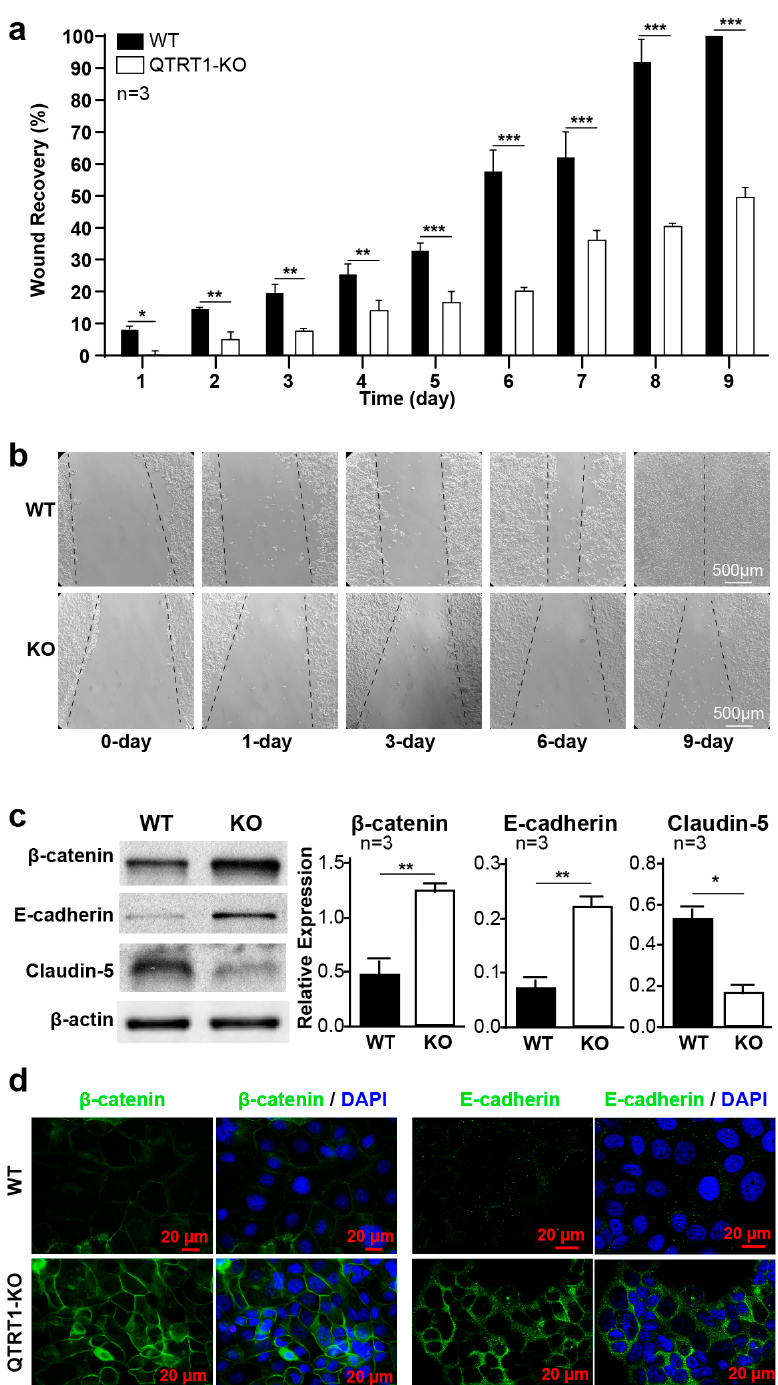
Figure 2. Knockout of QTRT1-suppressed cell migration and altered cell adhesion and tight junctions. ( a ) Wound healing analysis of wildtype and QTRT1-KO MCF7 cells was shown as the percentage of scratch closure at day timepoints. Mean ± SD, n = 3; * p -value < 0.05, ** p -value < 0.01, *** p -value < 0.001, two-tailed Welch’s t -test. ( b ) Representative wound healing images were shown. Scale bar is 500 µm. ( c ) Western analysis of tight junction protein E-cadherin, β -catenin, and caludin-5 was performed on QTRT1 knockout and WT MCF7 cells. Mean ± SD, n = 3; * p -value < 0.05, ** p -value < 0.01, two-tailed Welch’s t -test. ( d ) E-cadherin and β -catenin immunofluorescence staining showing the protein expression in QTRT1-KO MCF7 cells compared with WT cells. Proteins and DNA were stained with mouse monoclonal anti- β -catenin/E-cadherin and anti-mouse Alexa Fluor 488 antibody and DAPI, respectively. Scale bar is 20 µm.